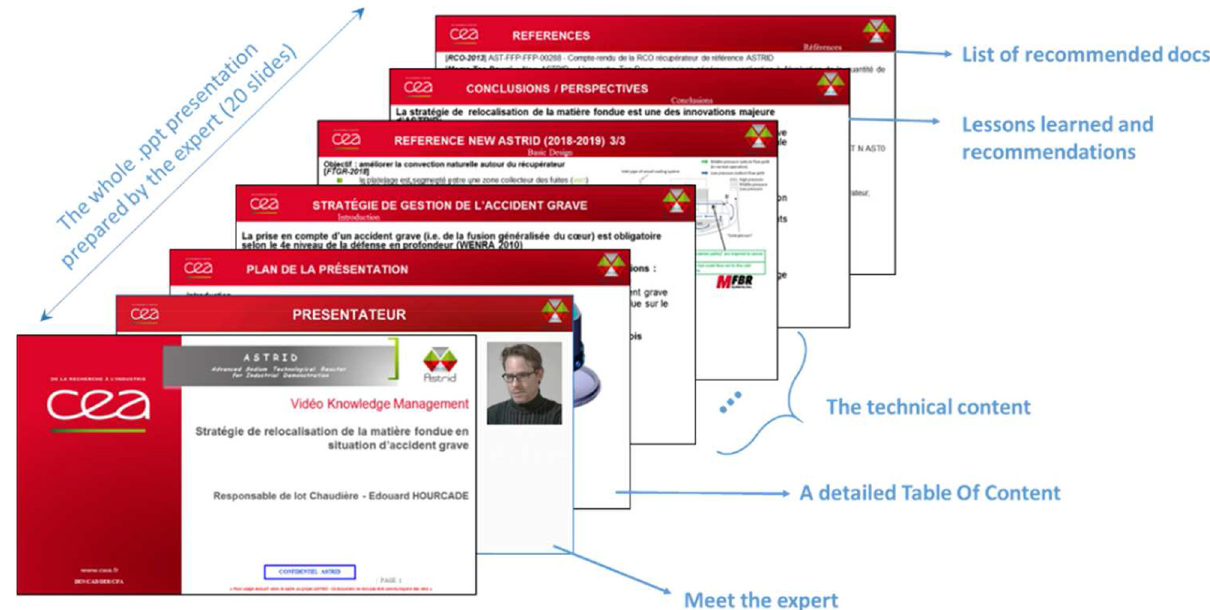
Fig. 3. The second step of a MOOK creation: Preparation of the .ppt presentation by the